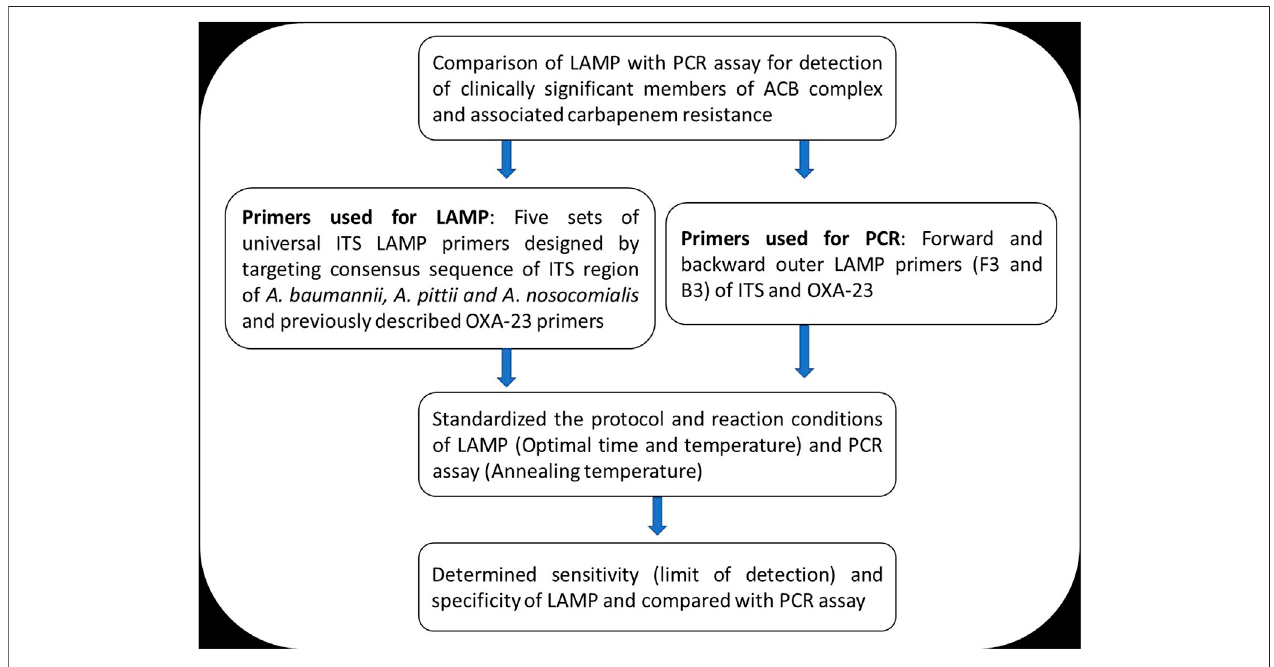
FIGURE 1 | Summary of the study work fl